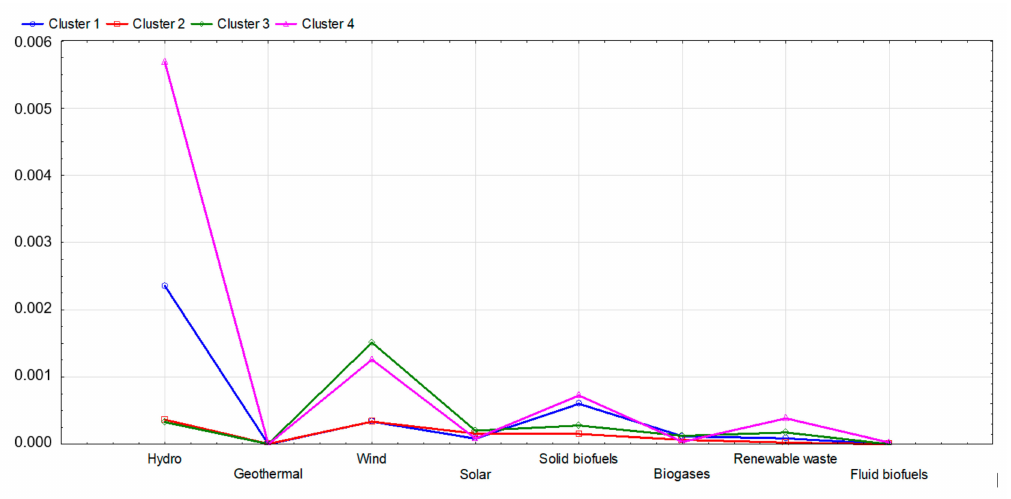
Figure 15. The Mean values of energy production from renewable energy sources in relation to the number of inhabitants for individual clusters (own